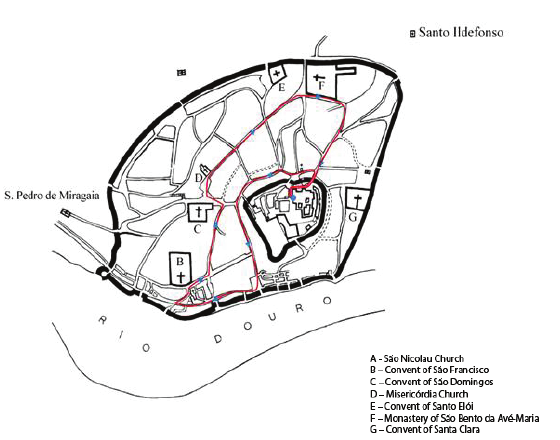
Figure 7: The procession of Corpus Christi after